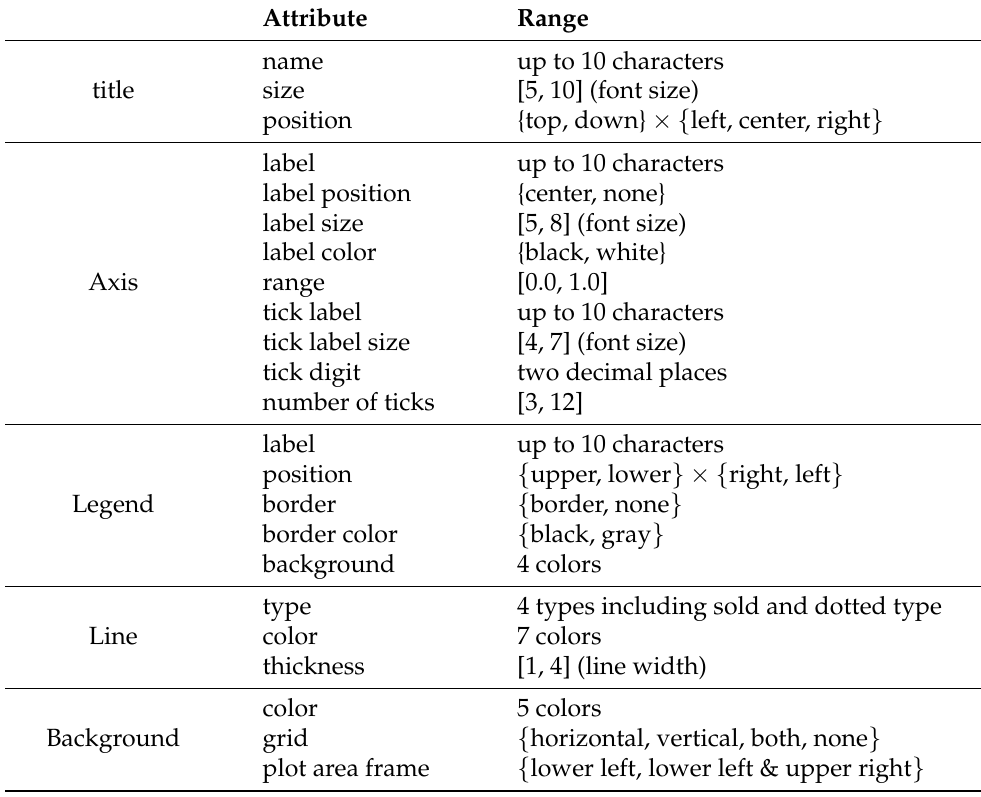
Table 1. Attributes of the frame of the targeted line chart